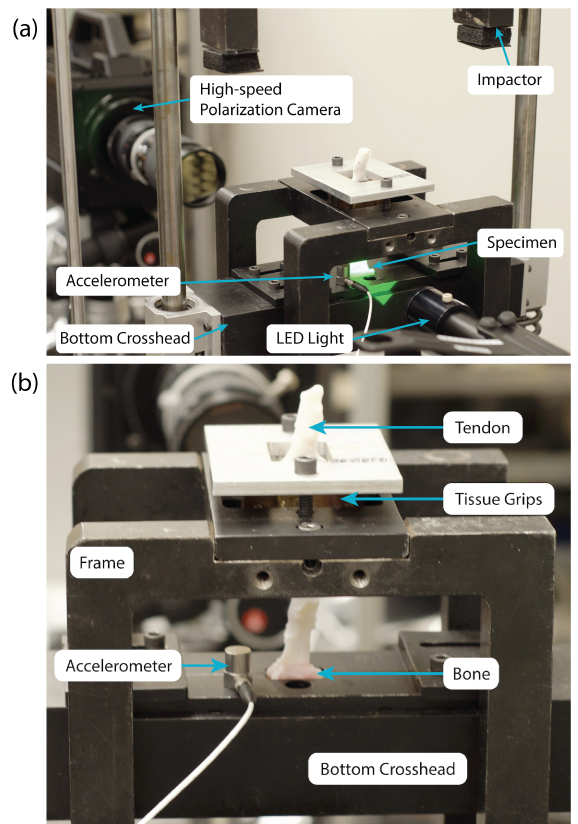
Figure 4. ( a ) Photograph of the high-speed polarization camera setup and modified drop tower. ( b ) Closeup of a tendon-to-bone insertion specimen in